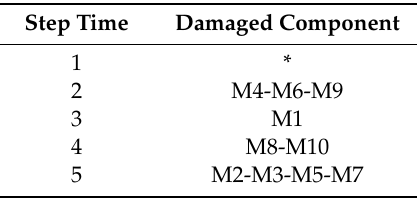
Table 7. The optimal priority list of the damaged components in the 66 bus case.